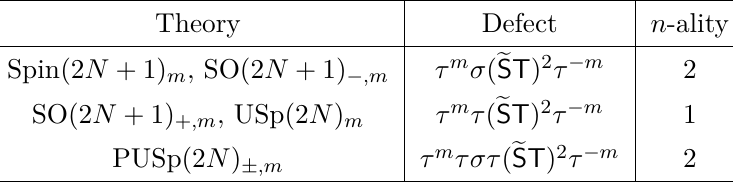
for N odd. For 2